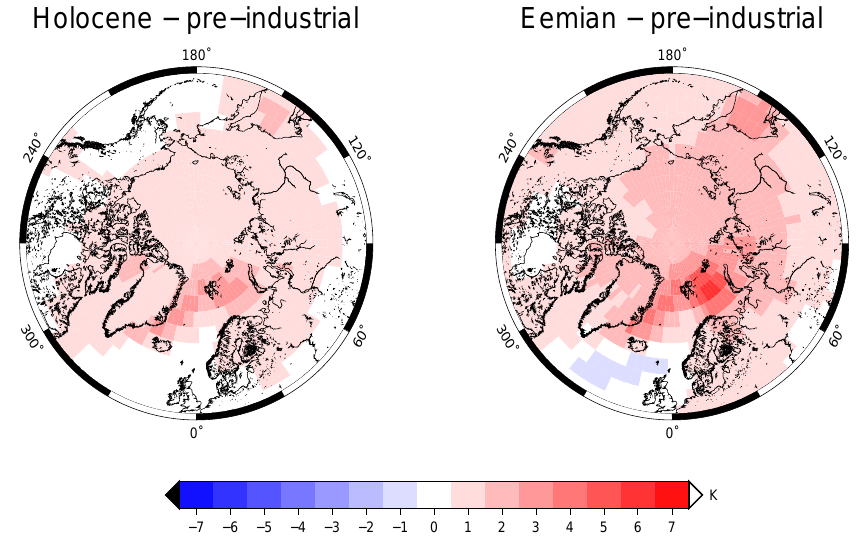
Fig. 2. Temperature changes (in K) in the Arctic region for the Holocene and the Eemian compared to pre- industrial climate.